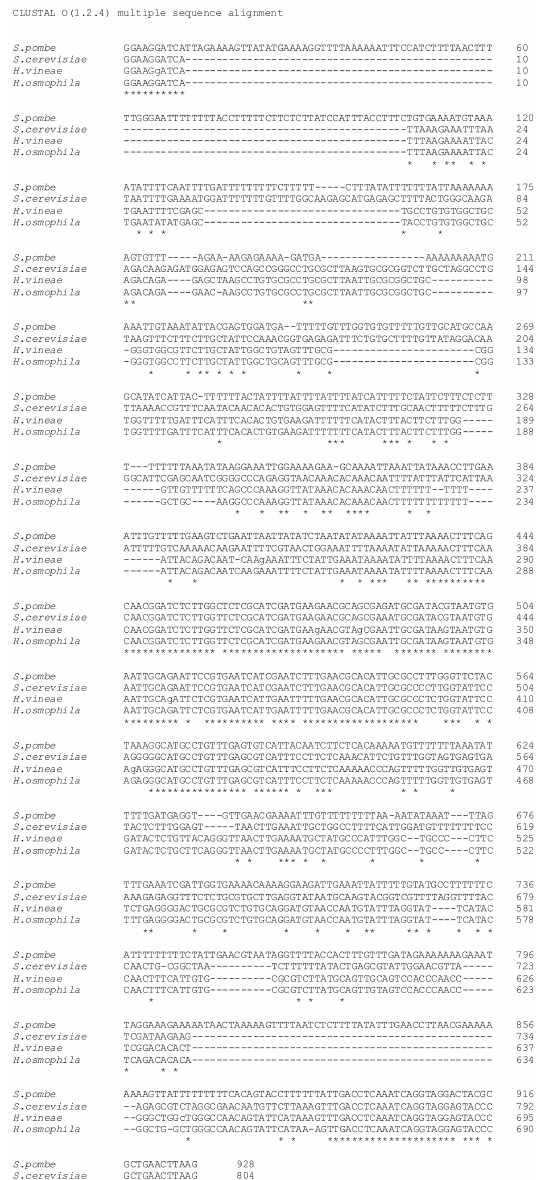
Figure A1. Phylogenetic relationships among wine yeast species based on analysis of ITS gene se- quences.